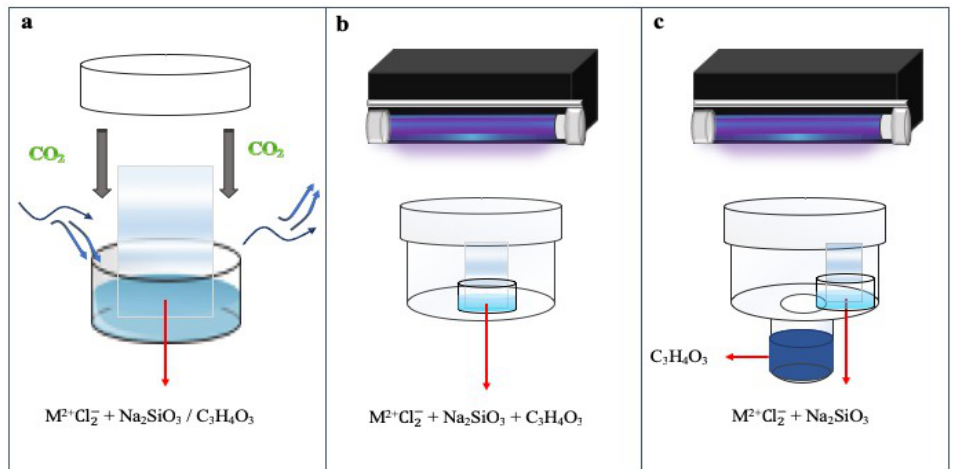
Figure 1. Schematic representation of the biomorphs growth systems. ( a ) Gas-diffusion method. ( b ) Single-phase method under UV radiation. ( c ) Gas-diffusion method under UV radiation. M = Ba or Sr.